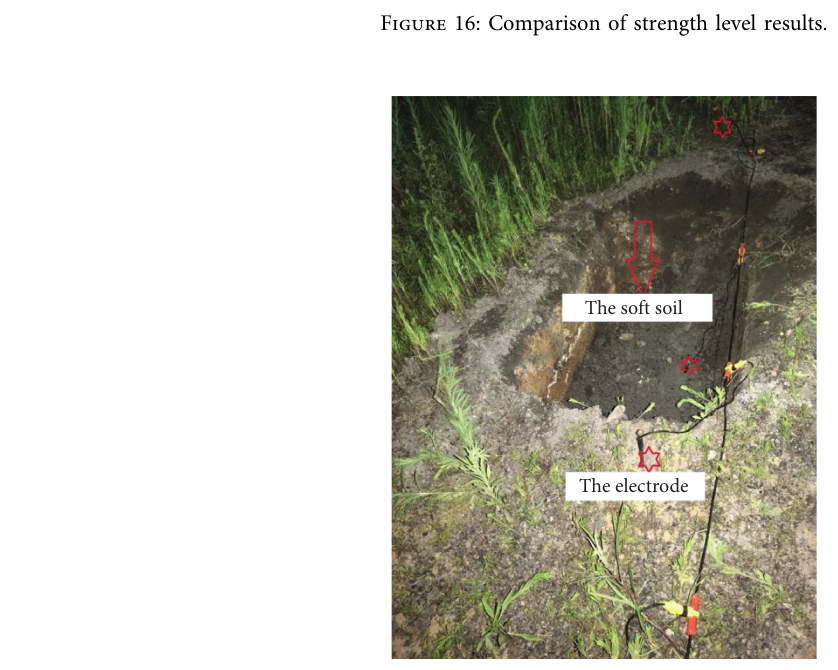
Figure 17: Experimental site images.